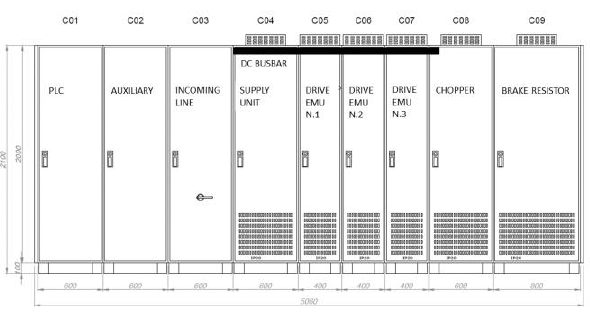
Fig. 13. Dimensional drawing of the electrical control panel.